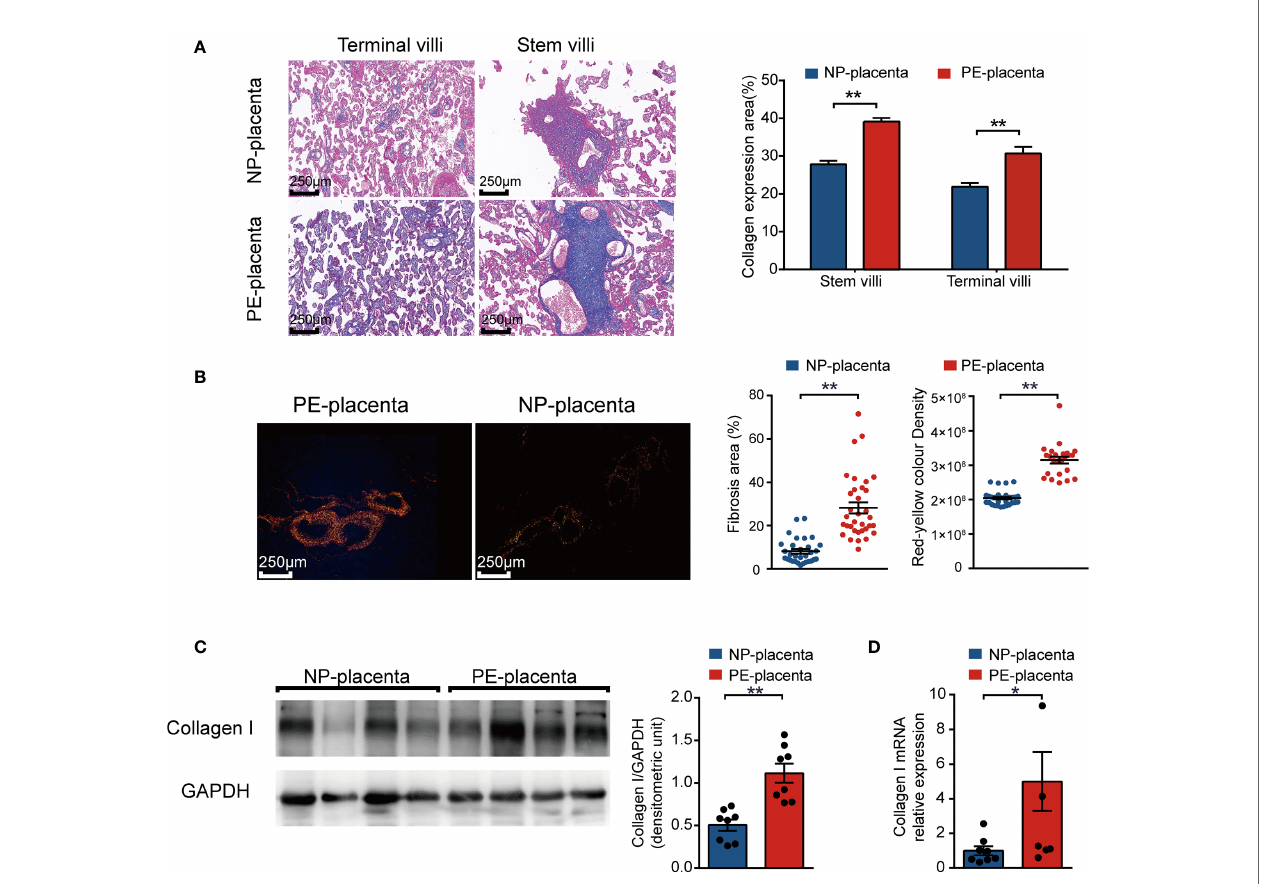
FIGURE 1 | Identi fi cation and quanti fi cation of collagen types in human preeclamptic (PE) placentas. (A) Masson ’ s trichrome staining of placentas in the stem and terminal villus region from normotensive pregnant women (NP placenta) and from PE patients (PE placenta; n = 6 per group, scale bar = 250 nm). Collagen expression area of PE and NP placentas. Collagen fi bers were stained blue, while cytoplasm and red blood cells were stained red, and the nucleus blue and brown. (B) Representative image of Sirius red staining of placenta (magni fi cation, 200×). Measured area and red-yellow color intensity of Sirius Red staining in PE and NP placenta (three visual fi elds for each placental sample, n = 6 per group). (C) Representative image of western blotting and quantitative analysis of collagen I in PE and NP placenta (bar chart, n = 8 per group). (D) Relative gene expression of collagen I (bar chart, n = 8 per group). Data are presented as mean ± standard error of mean (SEM). *p < 0.05, **p < 0.01 by two-tailed unpaired t -test